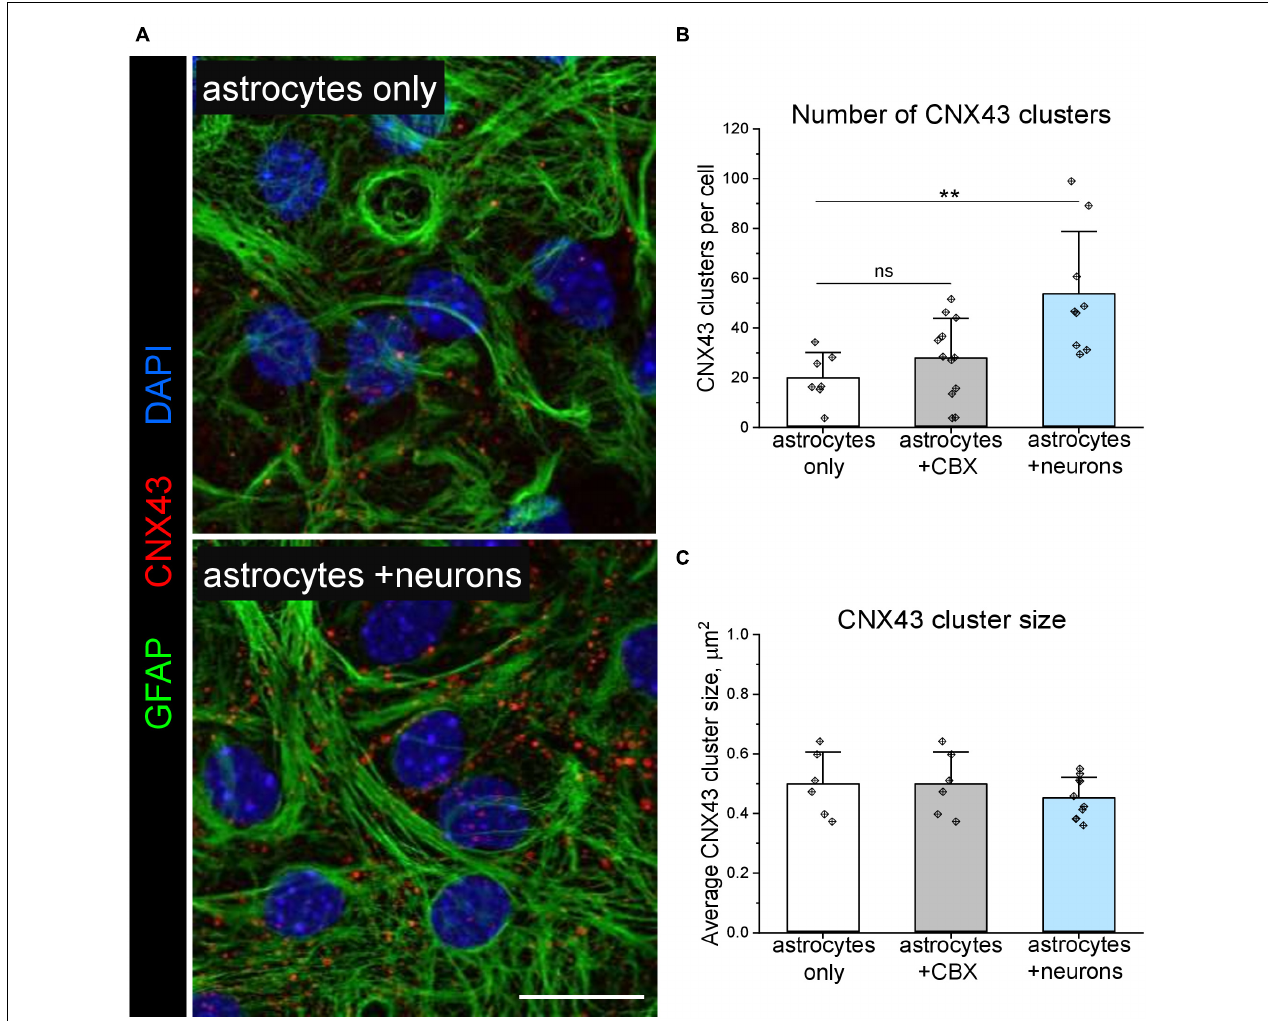
FIGURE 6 | Expression of gap junctions and hemichannels formed by connexin 43 in astrocytic networks cultivated with and without neurons. (A) Representative immunolabelling of glial acidic fibrillary protein (GFAP, green) and connexin 43 (CNX43, red) in pure astrocytes, and astrocytes co-cultivated with neurons. Nuclei are labelled with DAPI (blue). Scale bar, 20 µ m. Quantification of CNX43 cluster density (B) and size (C) is shown. Bars show mean ± SD, diamonds are data points. ** p < 0.01, based on two-way ANOVA and post hoc two-tailed independent Student’s t -test. n =